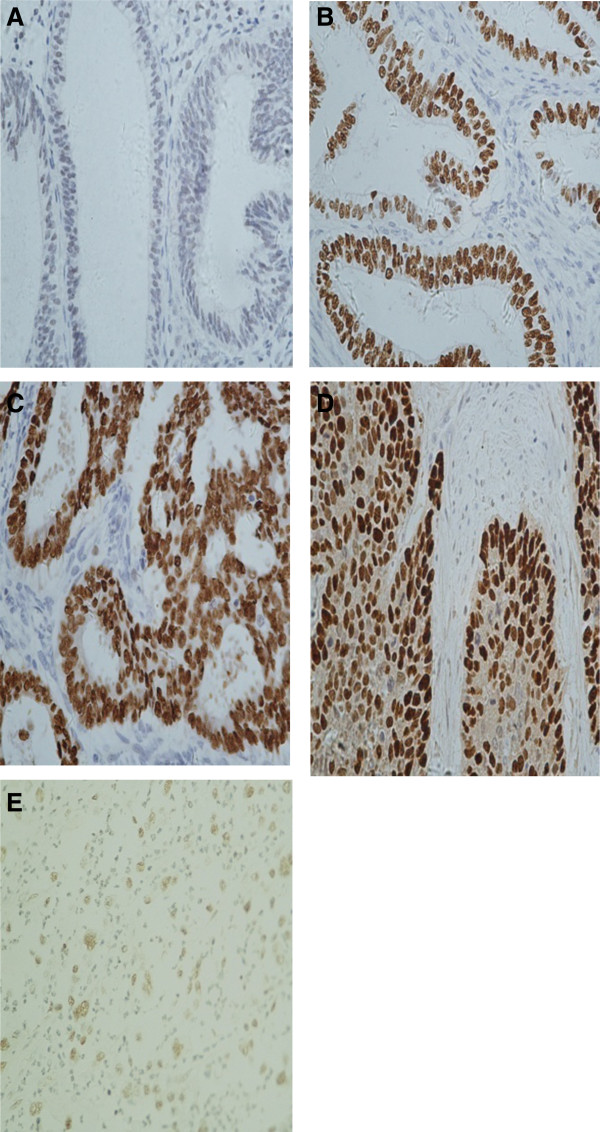
The expression of CyclinD1 tested by immunohistochemistry. (original magnifications: 400×). A: CyclinD1 immunostaining in simple hyperplasia endometrial tissue, cells with a brown-stained nucleus are regarded as positive. However, negative CyclinD1 immunostaining was seen in the picture. (original magnifications: 400×); B:CyclinD1 staining in atypical complex hyperplasia. CyclinD1 is weakly to moderately positive in most grandular epithelium cells (original magnifications: 400×); C: CyclinD1 staining in endometrioid carcinoma. CyclinD1 was strongly and diffusely positive in nucleus (original magnifications: 400×). D: CyclinD1 staining patterns in endometrial serous carcinoma, CyclinD1 expression in ESC mostly showed a strong intensity in nucleus. (original magnifications: 400×). E:SET8 expression in endometrial clear cell carcinoma. The picture showed a moderate intensity of SET8 staining. (original magnifications: 400×).